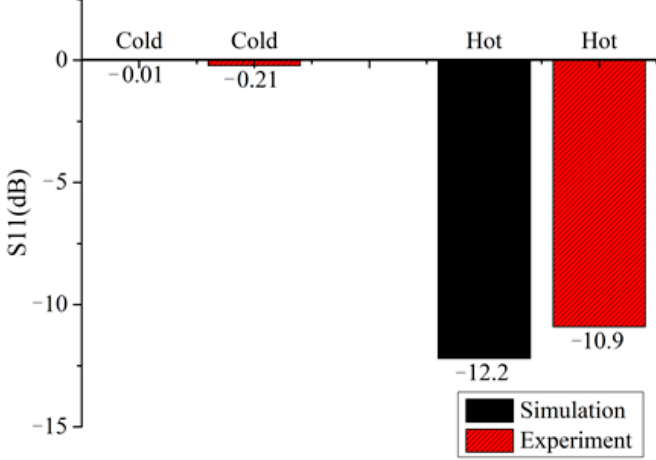
Figure 15. Comparing the S11 in different states.